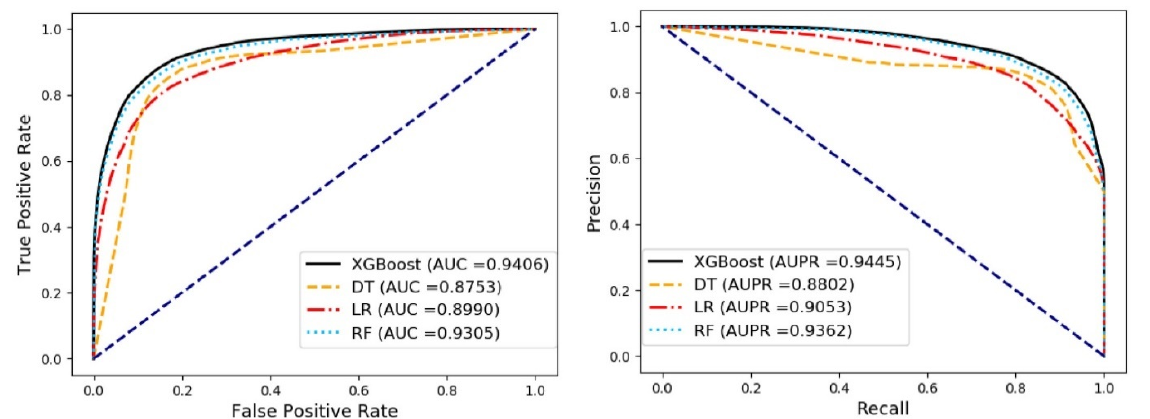
Figure 2. Comparison of SMMDA with random forest, logistic regression, decision tree and XG- Boost classifiers.